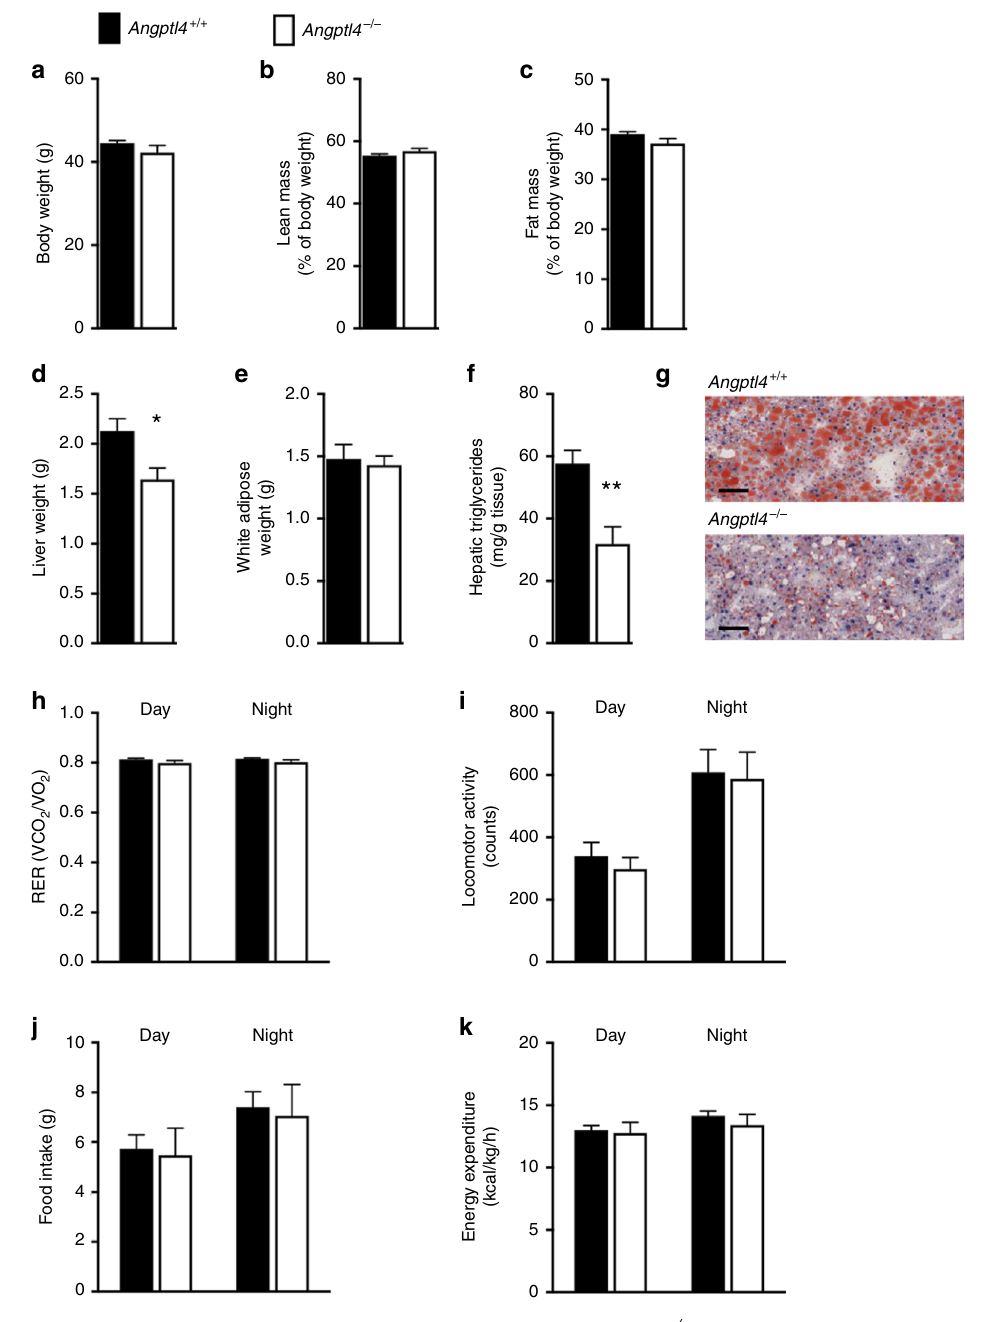
Fig. 5 Angptl4 − / − mice have reduced liver fat. a Body weight, ( b ) lean and ( c ) fat mass in Angptl4 − / − and littermate control mice on a high-fat diet. d Liver and ( e ) epididymal white fat weights were evaluated in mice described in ( a – c ) at the time of killing. f Hepatic triglyceride levels and ( g ) neutral lipid staining in the livers described in ( d ), scale bar = 200 µ m. h Respiratory exchange ratio (RER), ( i ) locomotor activity, ( j ) food intake, and ( k ) energy expenditure were measured during dark and light cycles in Angptl4 − / − and littermate control mice on a high-fat diet. All values are mean ± SEM. Statistical analysis was conducted by Welch ’ s t-test; * p < 0.05; ** p < 0.01. The study was conducted in two different cohorts of mice, with qualitatively similar results in each